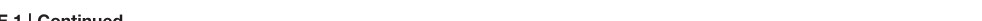
FIGURE 1 | Continued of Nestin-GFP cells (green) and BrdU immunoreactivity (red) in control (F , F ′ ) and Pros1-cHet (G , G ′ ) adult SGZ. (F ′ ,G ′ ) are close up views of the boxed areas in (F,G) , respectively. (H) Quiescent (radial) NSCs are easily detected as nestin-GFP + cells spanning the granule cell with elaborate dendritic arbors extending into the molecular layer (asterisks). Scale bar: (F,G) = 100 µ m; (H) = 20 µ M. (I) Western blot analysis of hippocampal cell extracts from the indicated mice. Blots were reacted for PROS1 (top), GFP (center), and GAPDH (bottom) as a loading control. A blot representative of four independent experiments is shown. (J) Morphology-based quantification of the radial glia-like quiescent NSCs dendritic arbors from mice with the indicated genotypes. Dendritic arbors were defined as GFP + ramifications extending from the granular layer into the molecular layer (asterisks in L ). Mean values and standard errors were derived from five individual mice per genetic group. * P = 0.04. (K,L) Quantification of nestin-GFP-positive cells by FACS, representing the total NSC population ( K ; * P = 0.04) and of nestin-GFP + ;GFAP − cells representing the horizontal NSC sub-population ( L ; * P = 0.017). Mean values and standard errors were derived from five individual mice per genetic